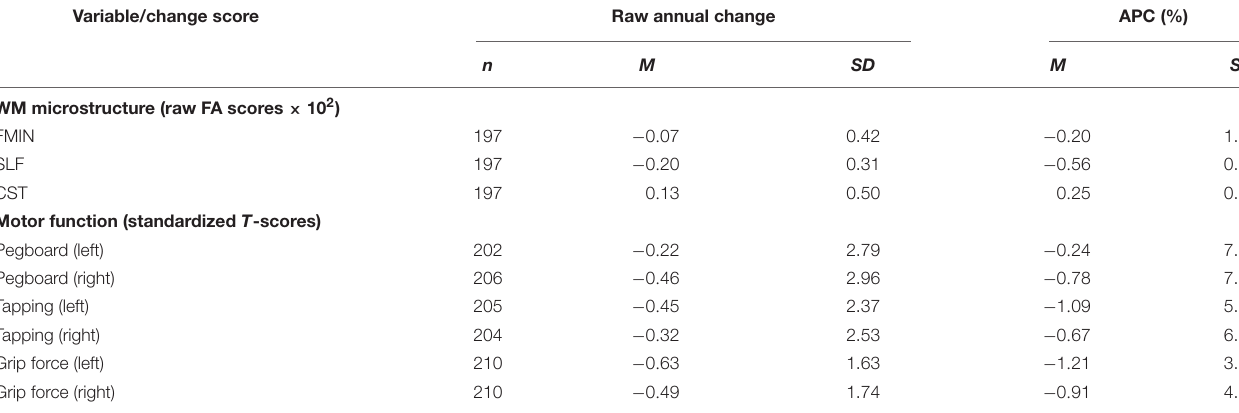
TABLE 2 | Raw annual change and annual percentage change of WM microstructure and motor function. Variable/change score